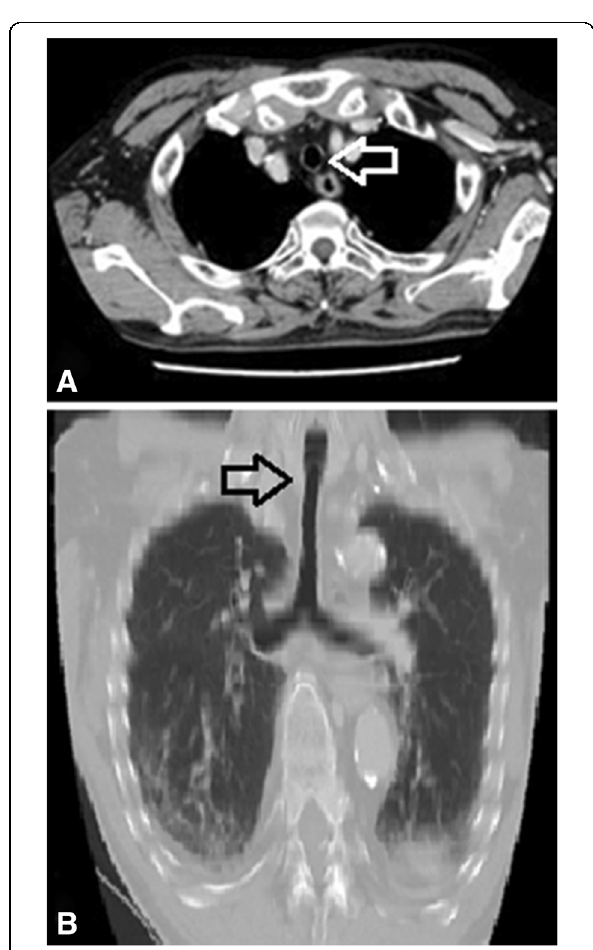
Fig. 2. CT imaging of complete tracheal rings. a Preoperative axial CT imaging of tracheal rings (arrow). b Postoperative coronal CT reconstruction (arrow). The tracheal diameter at the site of